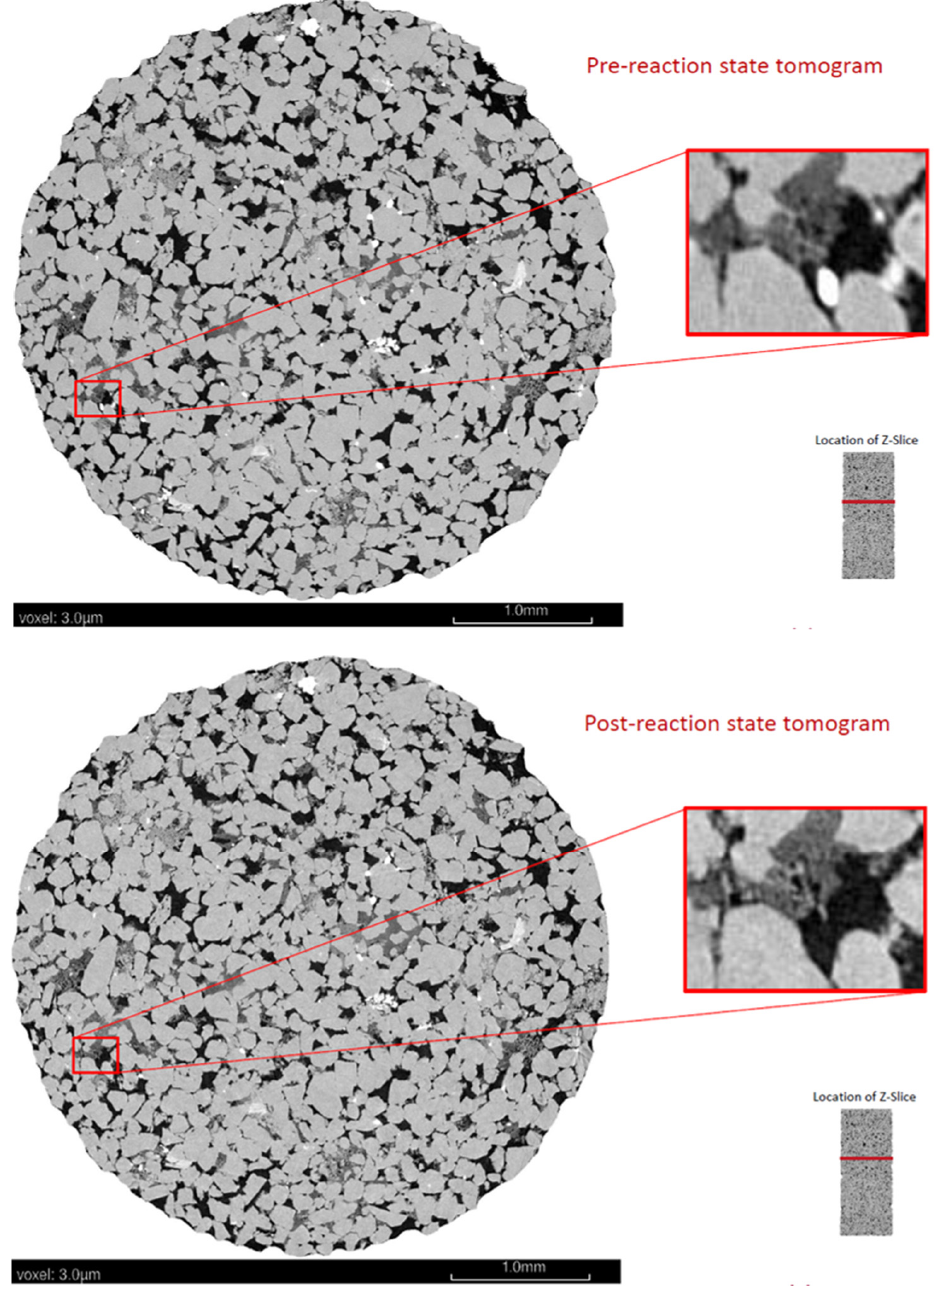
Figure 5. Pre- and post-reaction tomogram horizontal (z) plane images with magnified regions showing changes. The location of the image plane in the sub-plug is also indicated.